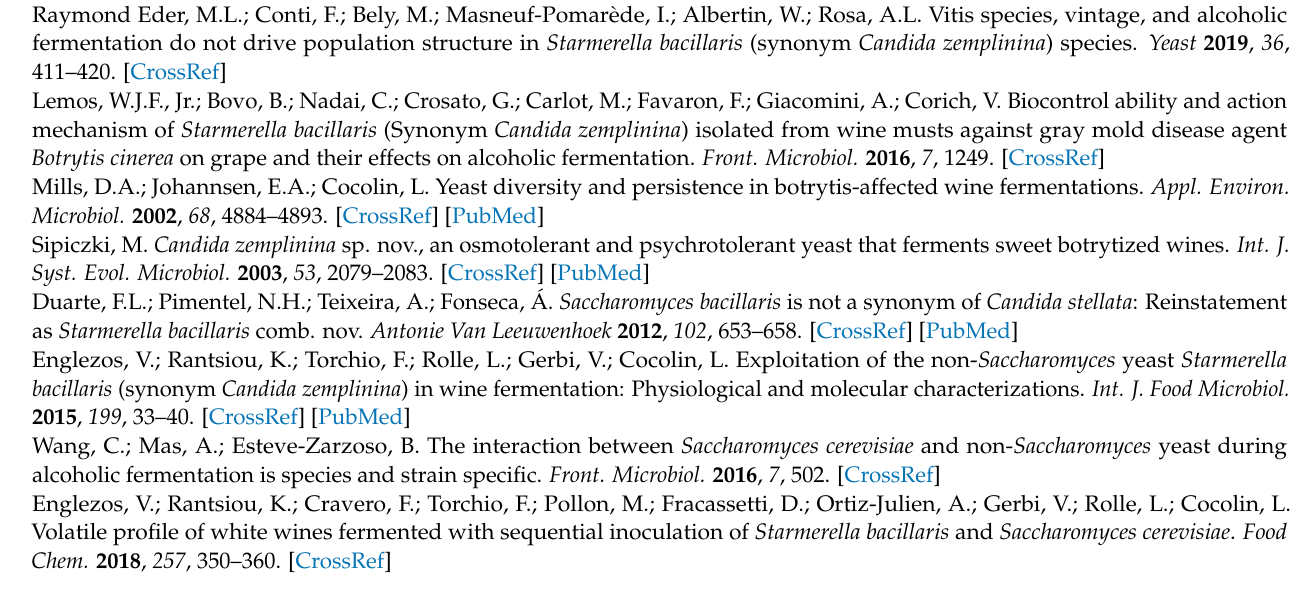
Table S2: Integrity assessment of genome assembly, Table S3: Statistics of repetitive sequences in the S. bacillaris CC-PT4 genome, Table S4: Statistics of non-coding RNAs, Table S5: Summary of predicted genes, Table S6: Stress responsive genes in S. bacillaris CC-PT4 genome, Table S7: S. bacillaris CC-PT4 whole-genome BLAST alignment with flocculin and adhesion proteins, Table S8: Drug resistance related genes in S. bacillaris CC-PT4 whole-genome, Table S9: List of carbohydrate-active enzyme genes in secreted